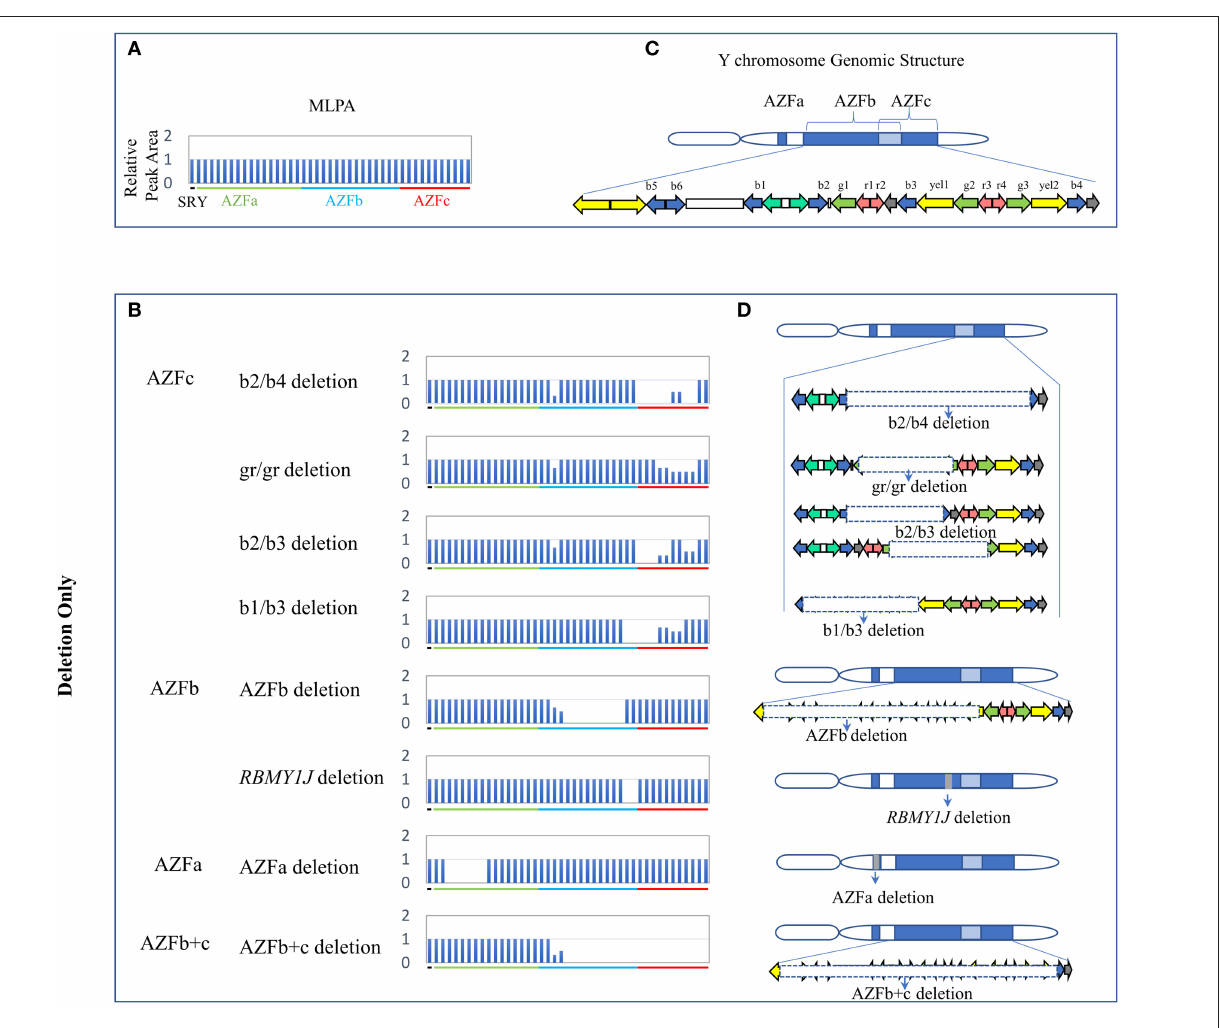
( P = 7.00 × 10 − 4 ), and oligozoospermia cases (OR = 2.44; controls ( Table 5